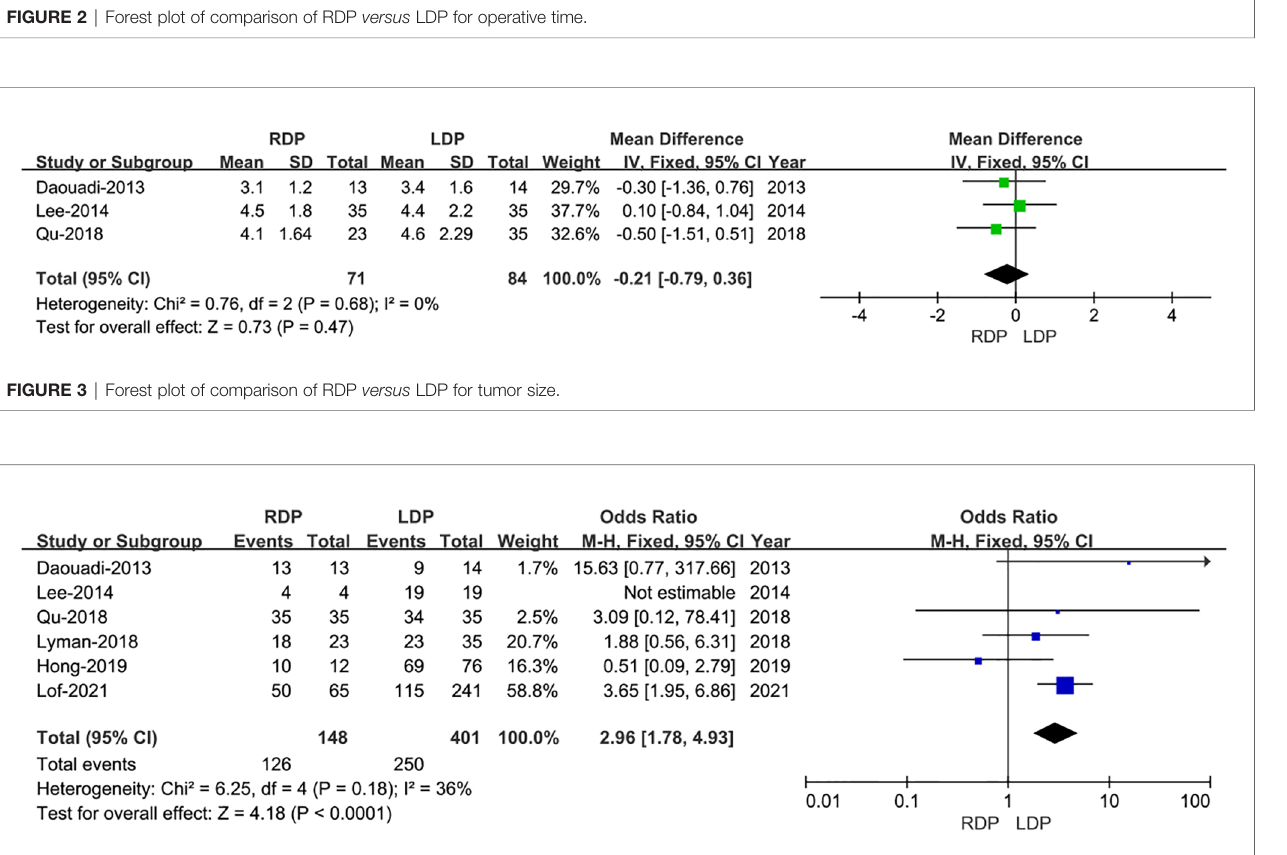
FIGURE 4 | Forest plot of comparison of RDP versus LDP for R0